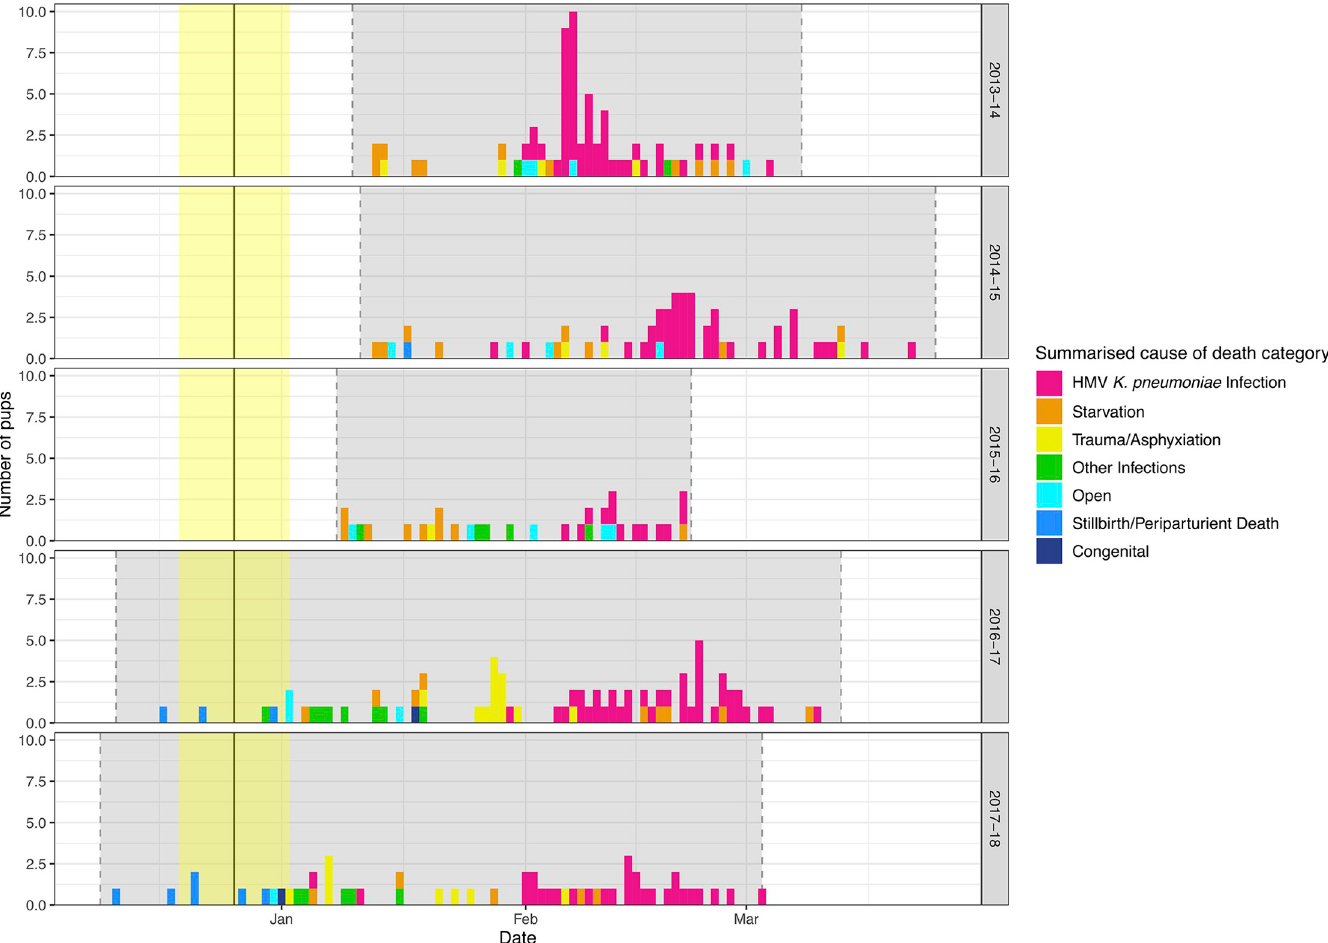
Fig 2. Histogram of summarised cause of death in New Zealand sea lion ( Phocarctos hookeri ) pups at Enderby Island presented by field season. Grey shaded area indicates the monitored period of each field season and yellow shaded area indicates the approximate timing of 69% of pupping with median pupping date of 26 December